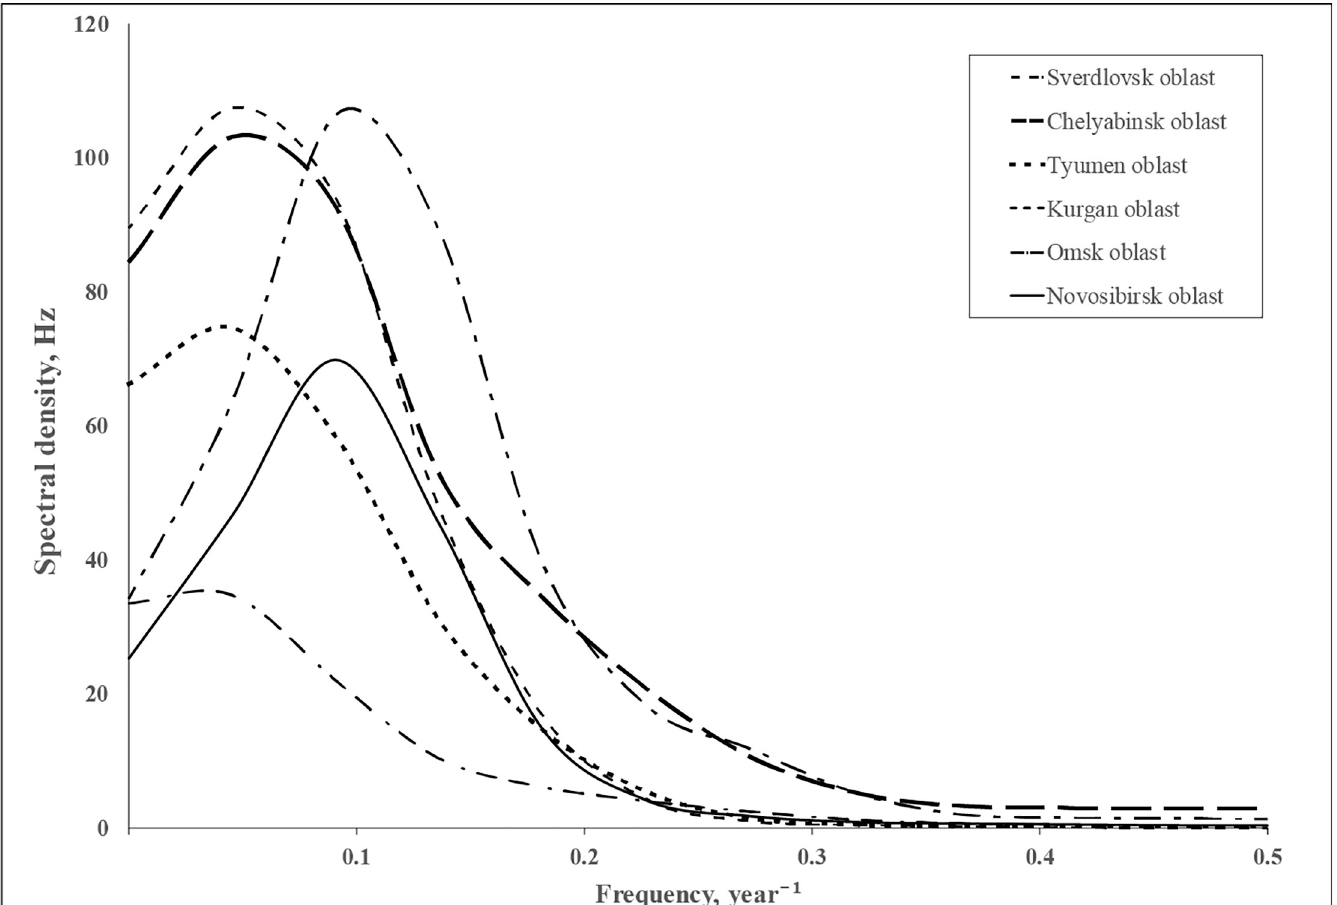
Fig 3. Spectral densities of log-transformed time series of squares of defoliated areas (ha).